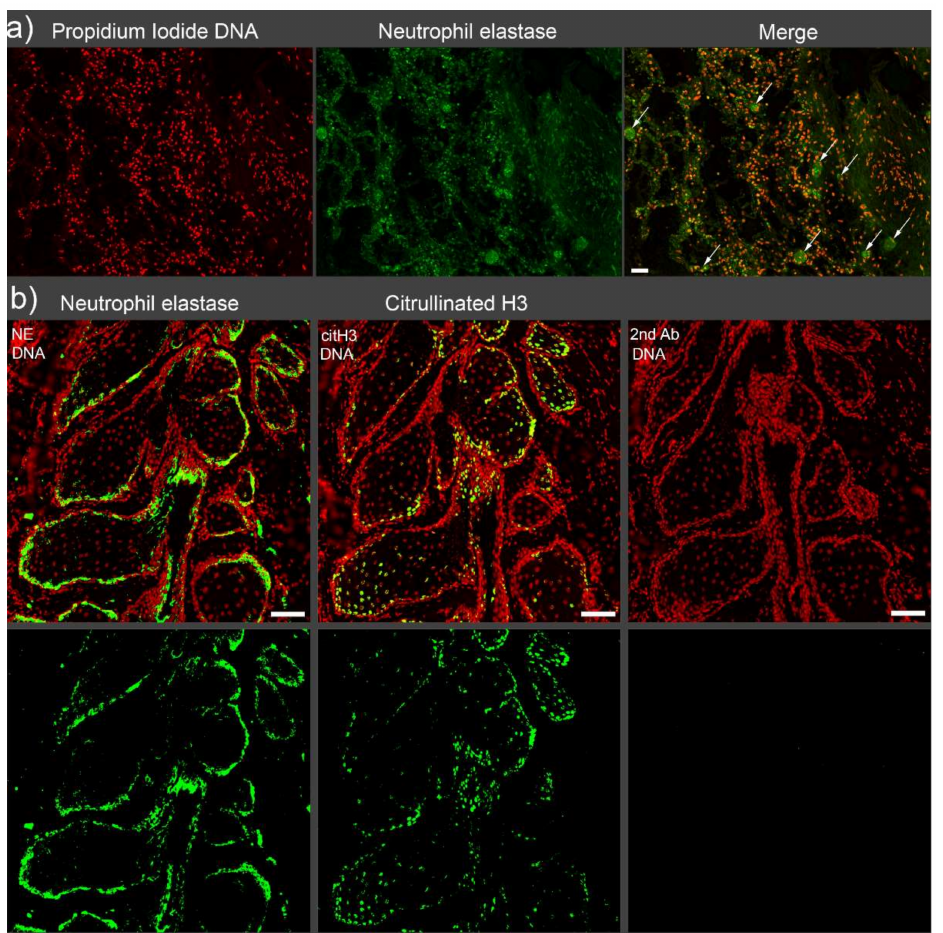
Figure 1. Immunofluorescence staining of AggNETs in the intravascular space and epithelial surfaces. ( a ) Neutrophil elastase (NE, green)-rich microvascular occlusions are observed in the alveolar area of a patient with deceased COVID-19. The occlusions are indicated with arrows in the merged image. Scale bar 50 µ m. ( b ) Aggregated NETs (NE and citrullinated histone 3, green) fill the epithelial surfaces of stagnated acini of Meibomian glands of a patient with acute blepharitis. Scale bar 100 µ